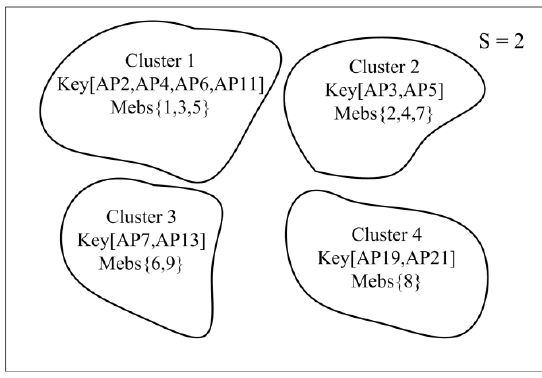
Figure 12. Clustering results with S = 2.